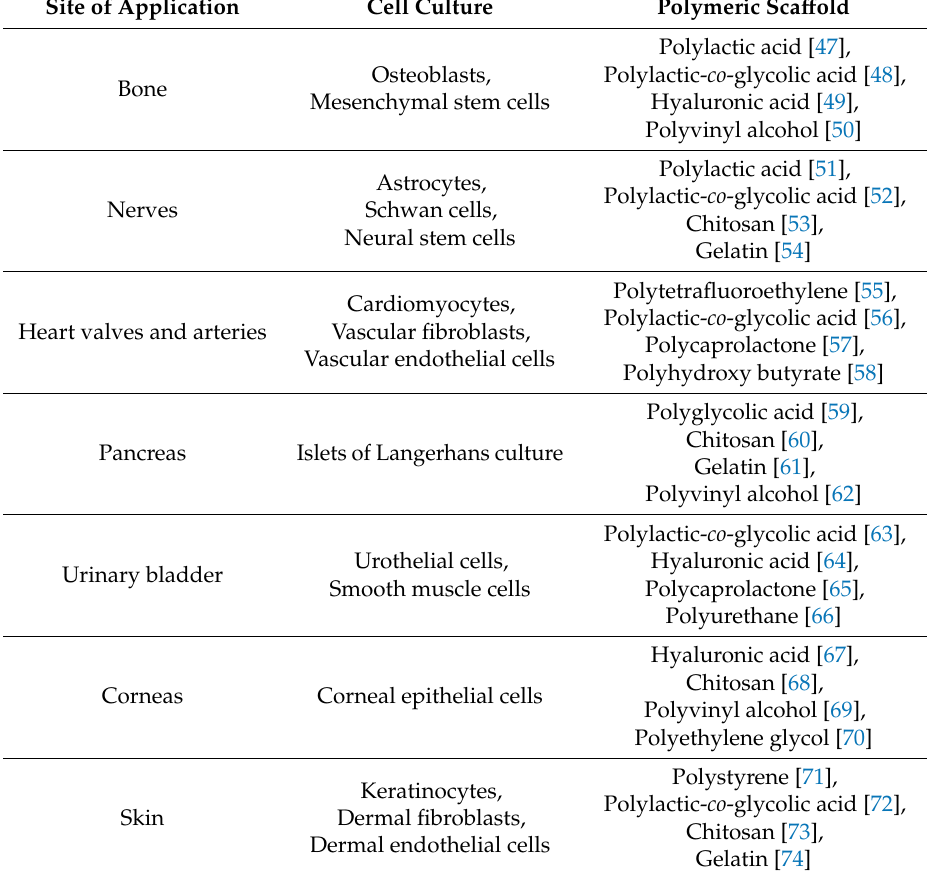
Table 1. Selected areas of tissue engineering together with the cultivated cell types and examples of polymers applicable as organic nanofibrous sca ff olds for cell